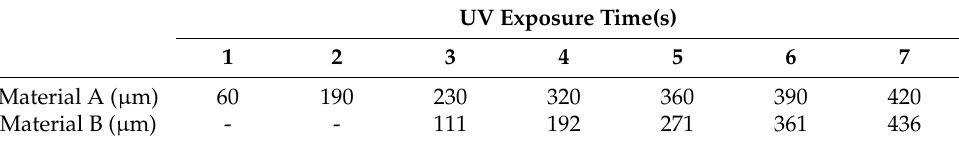
Table 3. Cured depth according to UV exposure